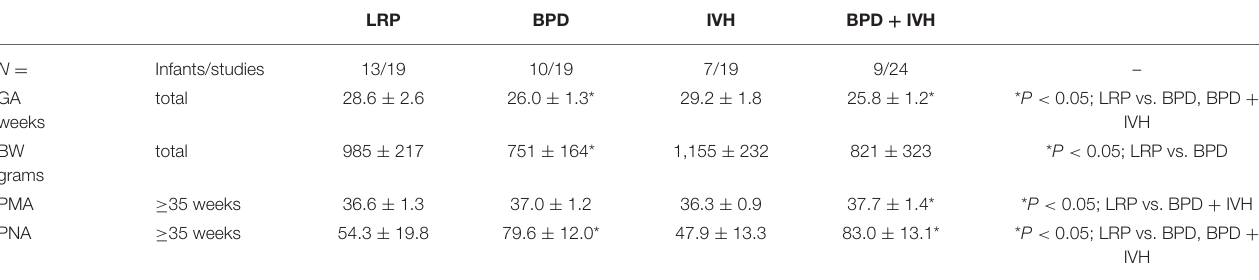
TABLE 1 | Population characteristics.